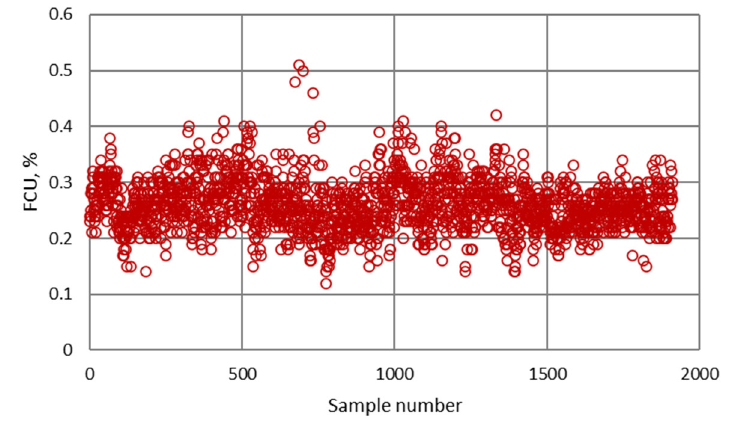
Figure A1. Copper content in feed (FCU)—input dataset.